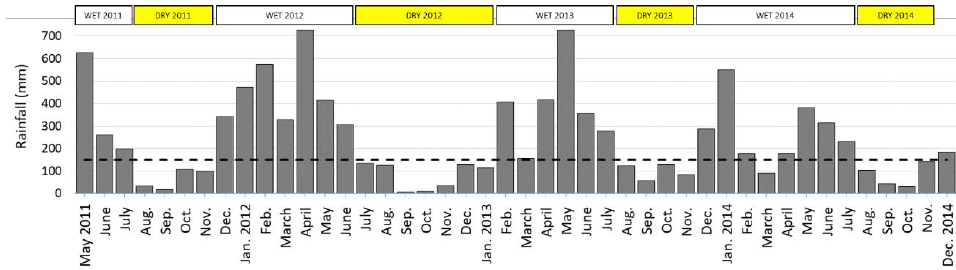
Figure 3. Monthly rainfall during the experiment (from May 2011 to November 2014) at the Combi